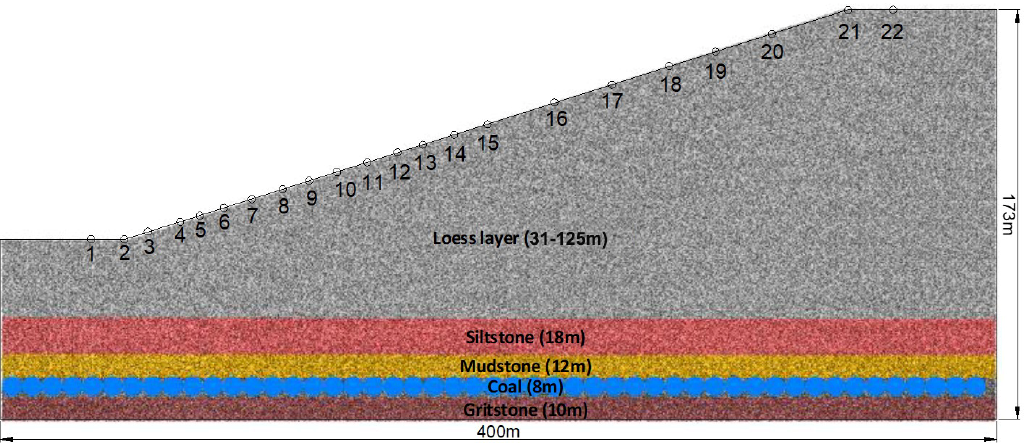
Figure 11. Numerical model of particle flow in the studied working face.